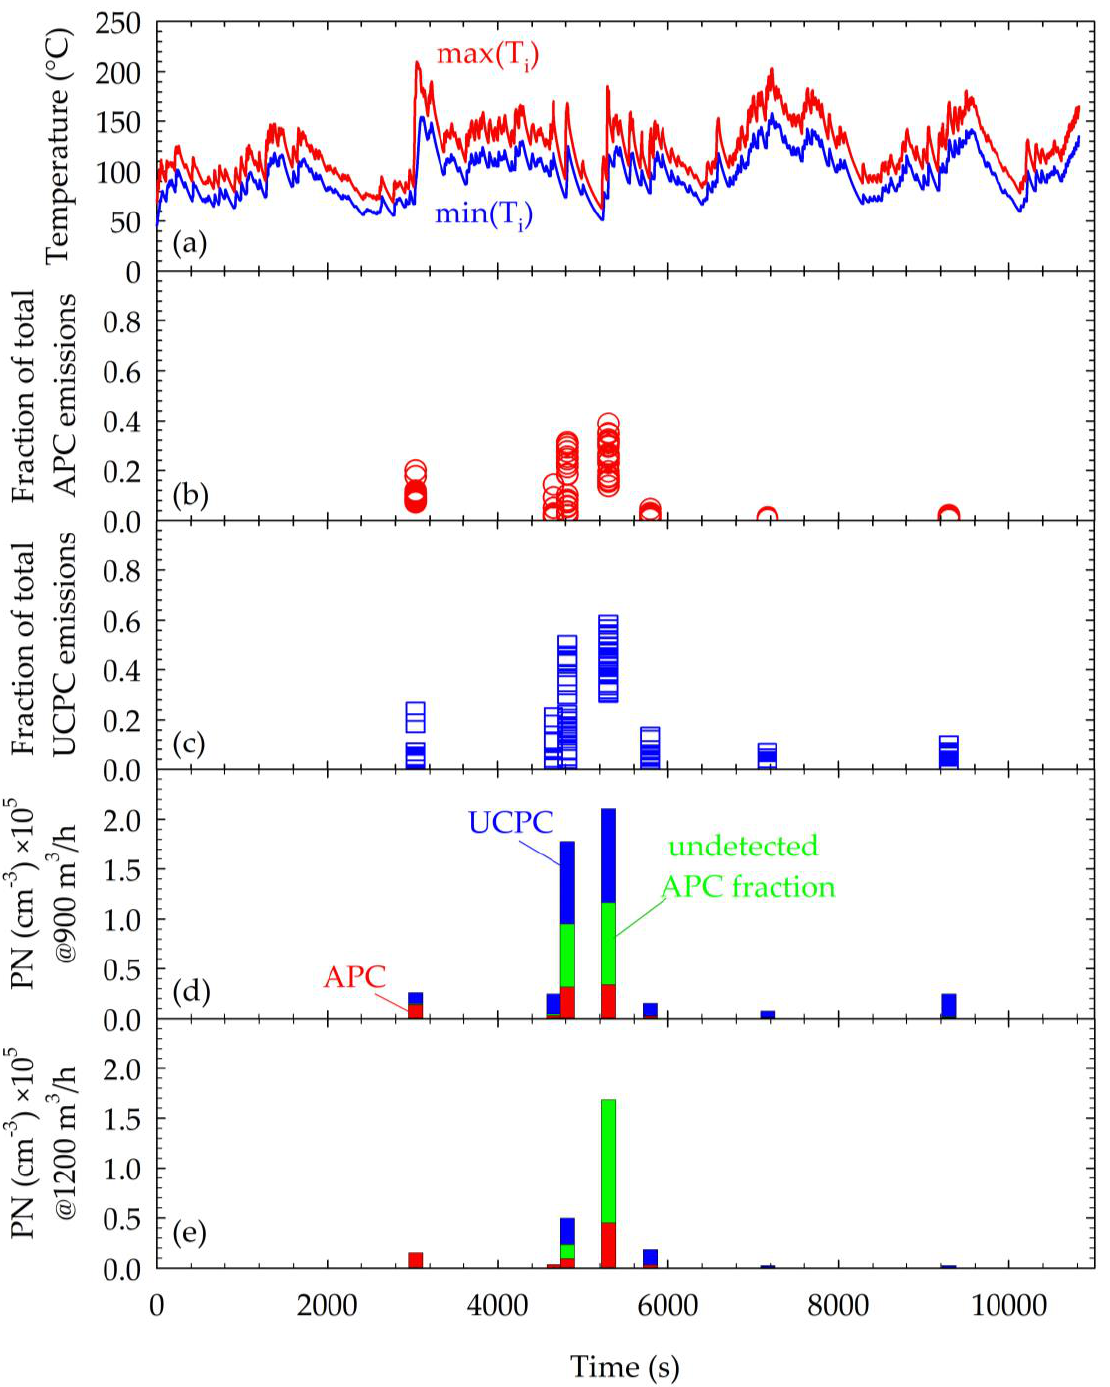
Figure 7. ( a ): Real-time traces of the maximum (red-lines) and minimum (blue-lines) temperatures measured from all repetitions of the 3h-LACT procedure and all 4 thermocouples. ( b ): Contribution of specific braking events on the total PN emissions of thermally treated samples (APC). ( c ): Contribution of specific braking events on the total PN emissions of untreated samples (CPC). ( d , e ): Twenty-second average concentrations measured with the APC (red bars) and the CPC (blue bars) over the specific brake events based on all LACT tests at 900 m 3 /h ( d ) and at 1200 m 3 /h ( e ). Estimated undetected APC fractions based on the corresponding EEPS distributions are shown as green bars.